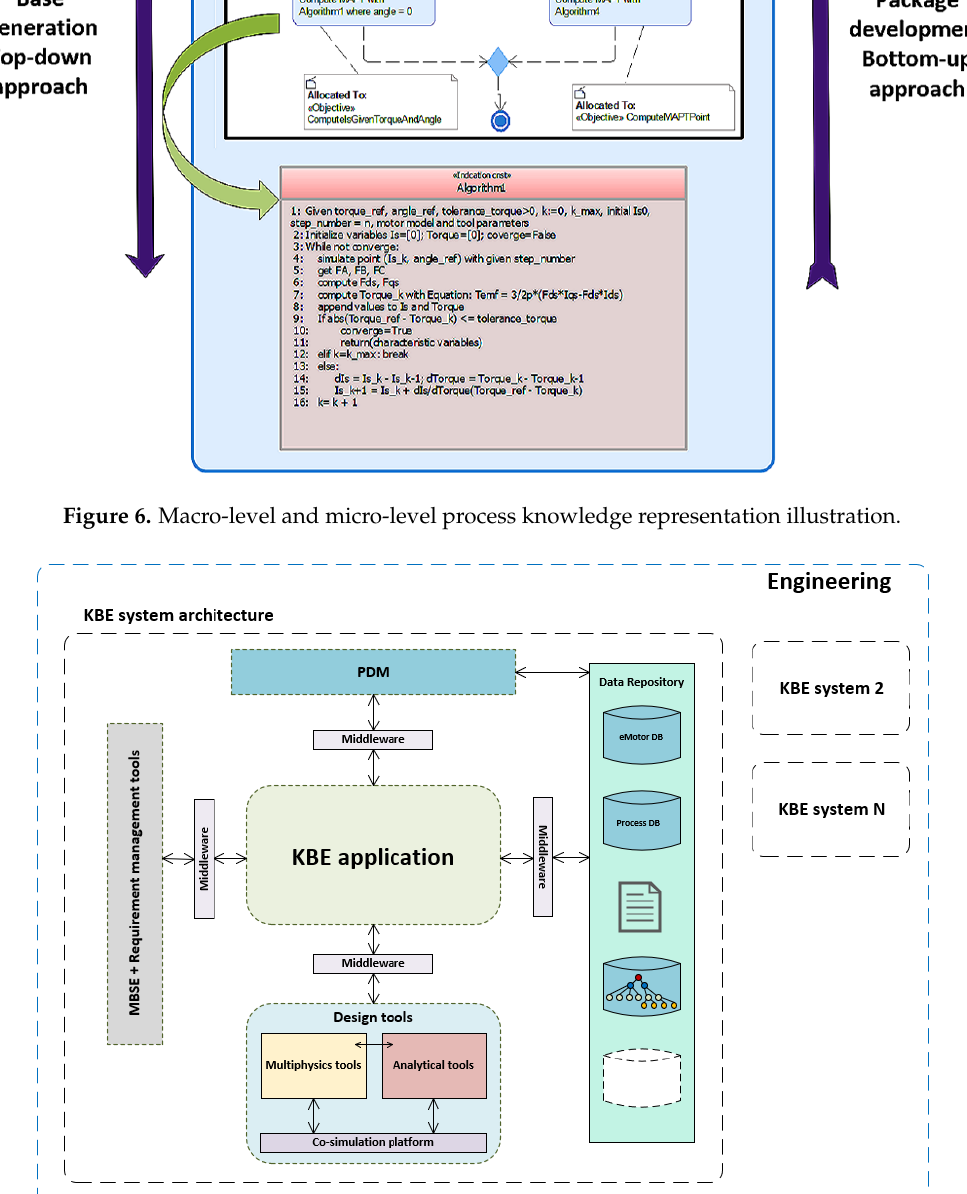
Figure 7. KBE system architecture.